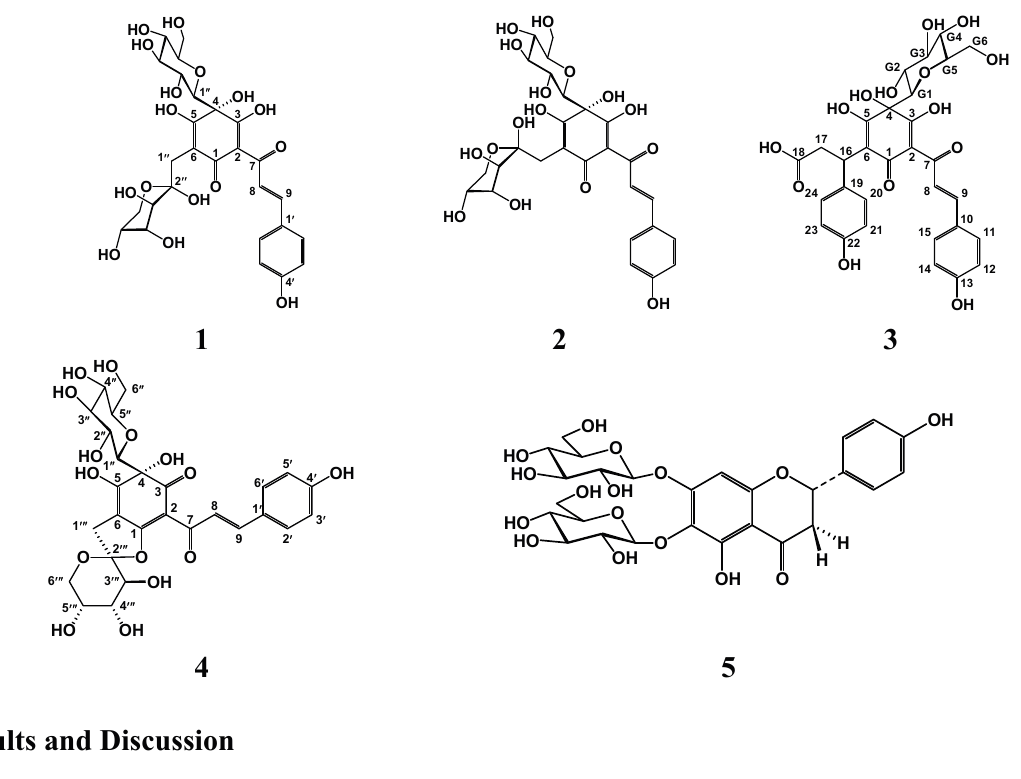
Figure 1. The chemical structures of compounds 1 – 5 isolated from Carthamus tinctorius